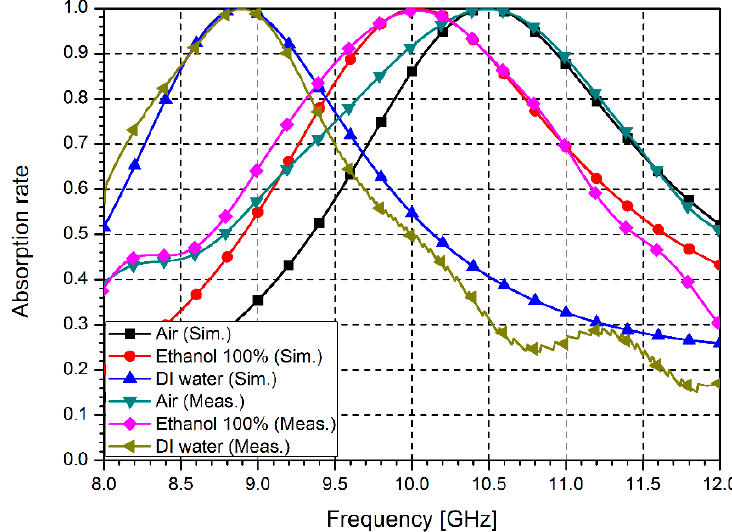
Figure 8. Simulated and measured absorption rates of the proposed metasurface absorber.